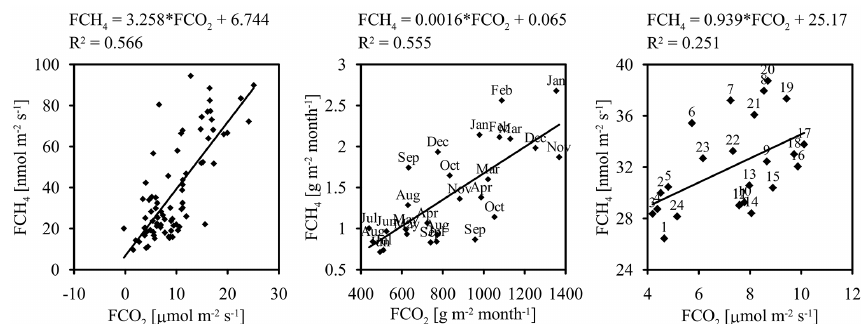
Figure 9. Mean daily (left), monthly (middle) and hourly FCH 4 fluxes against FCO 2 in the period July 2013–June 2015.